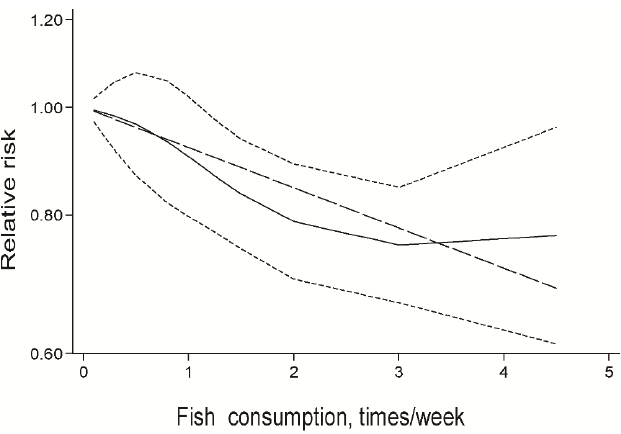
Figure 4. Dose-response relation between fish consumption and relative risks of AMD risk. Lines with short dashes represent the point wise 95% confidence intervals for the fitted nonlinear trend (solid line). Lines with long dashes represent the linear trend.